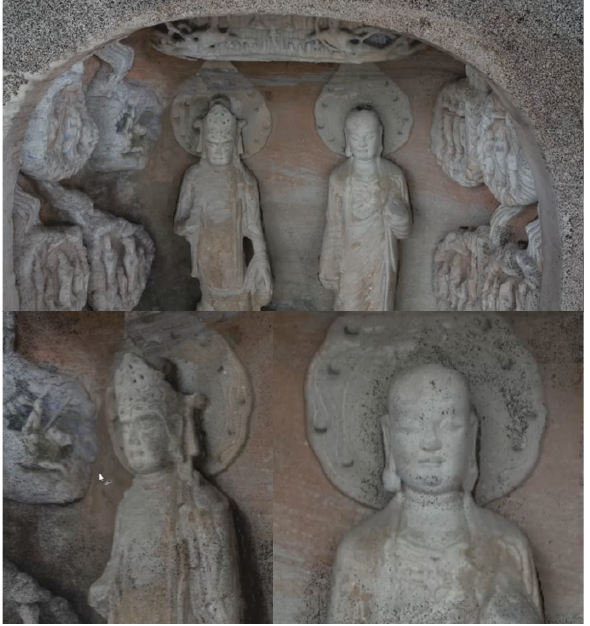
Figure 8: Expressions, gestures and full view of the niche No. 125 “Charming Avalokte ś vara” deity. 92 cm in height. Point cloud visualization.